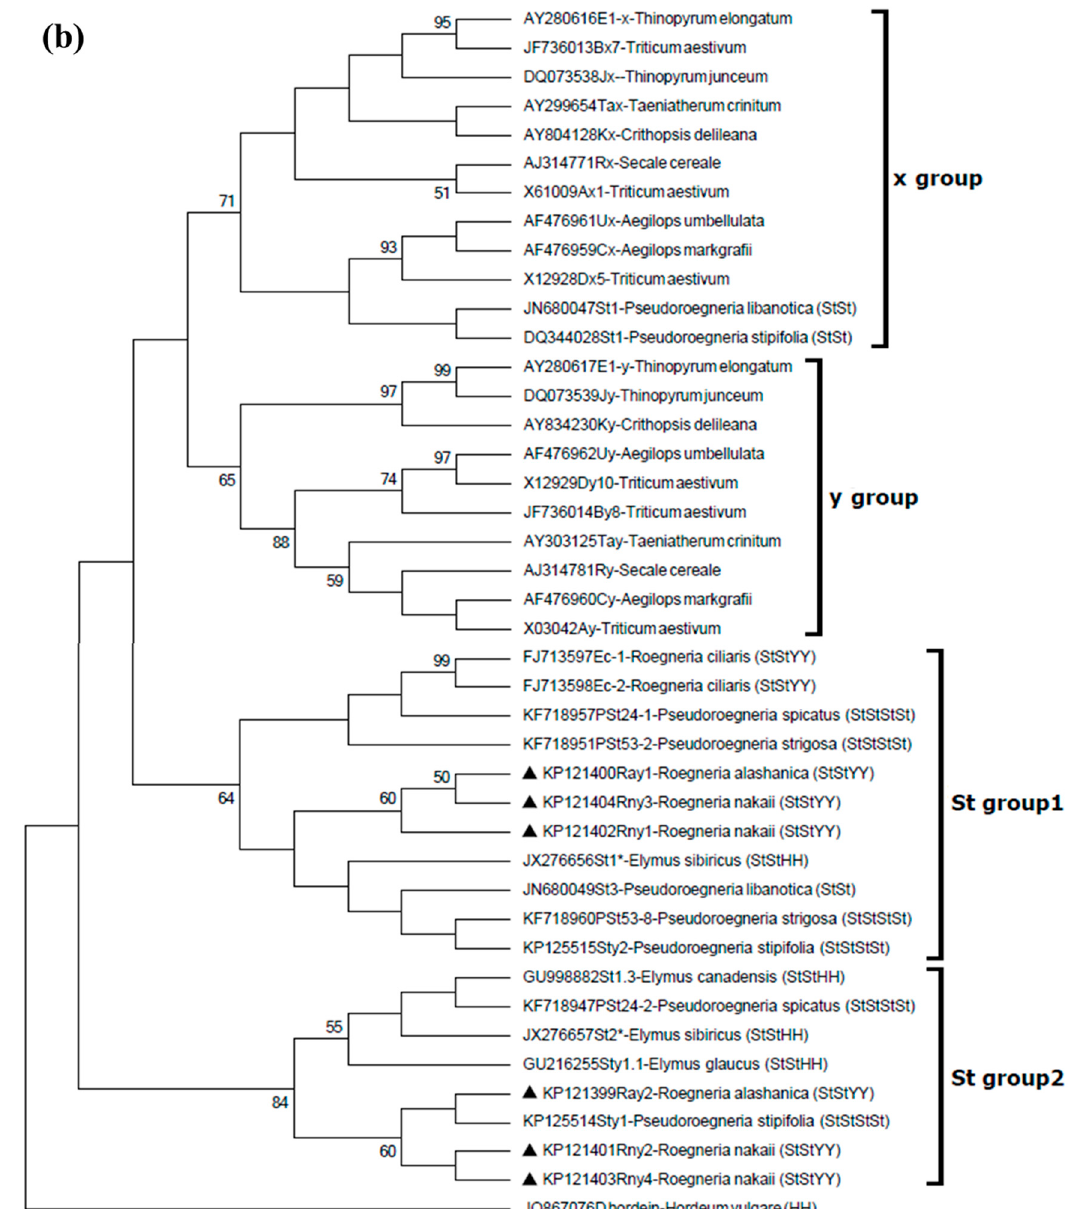
Figure 6. Phylogenetic trees of HMW-GSs from R. nakaii and R. alashanica and their orthologous subunits from wheat and other related species. The phylogenetic trees were constructed based on the amino acid sequences of N-terminal with the first three motifs of the central repetitive domain ( a ) and the C-terminal with the last six motifs of the central repetitive domain ( b ) using maximum likelihood method. Bootstrap values ≥ 50% estimated based on 500 replications are shown above the branches. The six novel Roegneria subunits are marked by solid triangles.